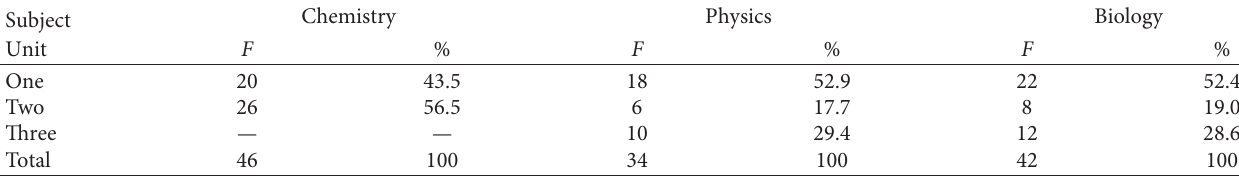
Table 12: Question distribution based on the wage of importance in each unit in the textbook.